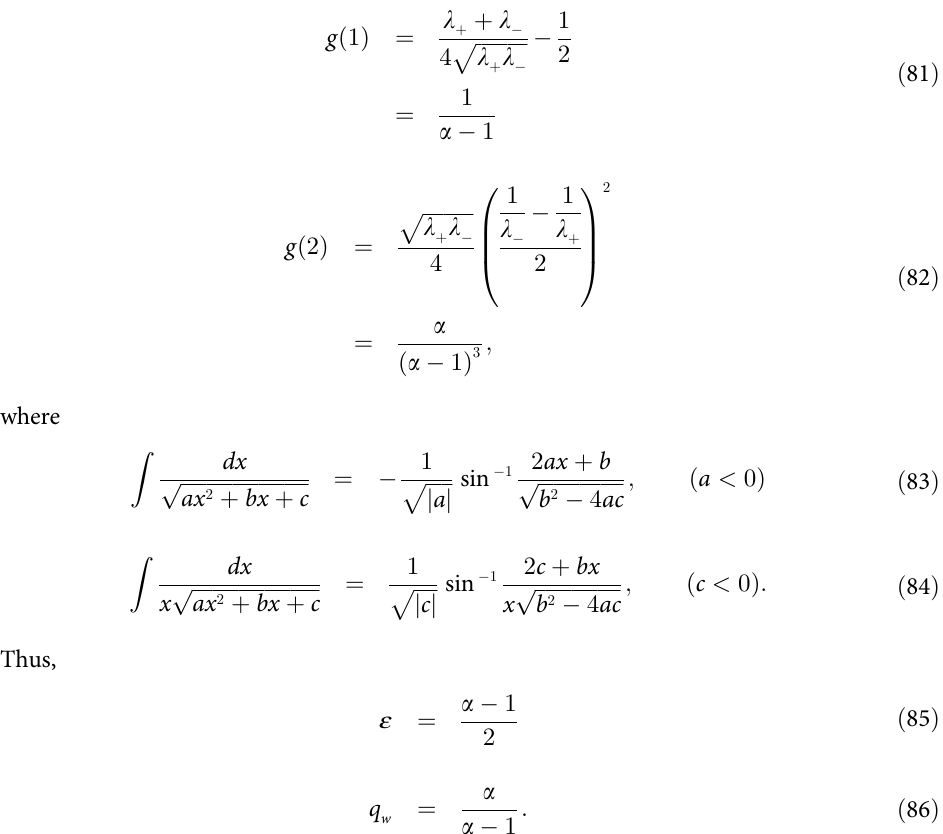
dx ffiffiffiffiffiffiffiffiffiffiffiffiffiffiffiffiffiffiffiffiffiffiffiffiffi ffiffiffiffiffiffiffiffiffiffiffiffiffiffiffiffiffiffiffiffiffiffiffiffiffi